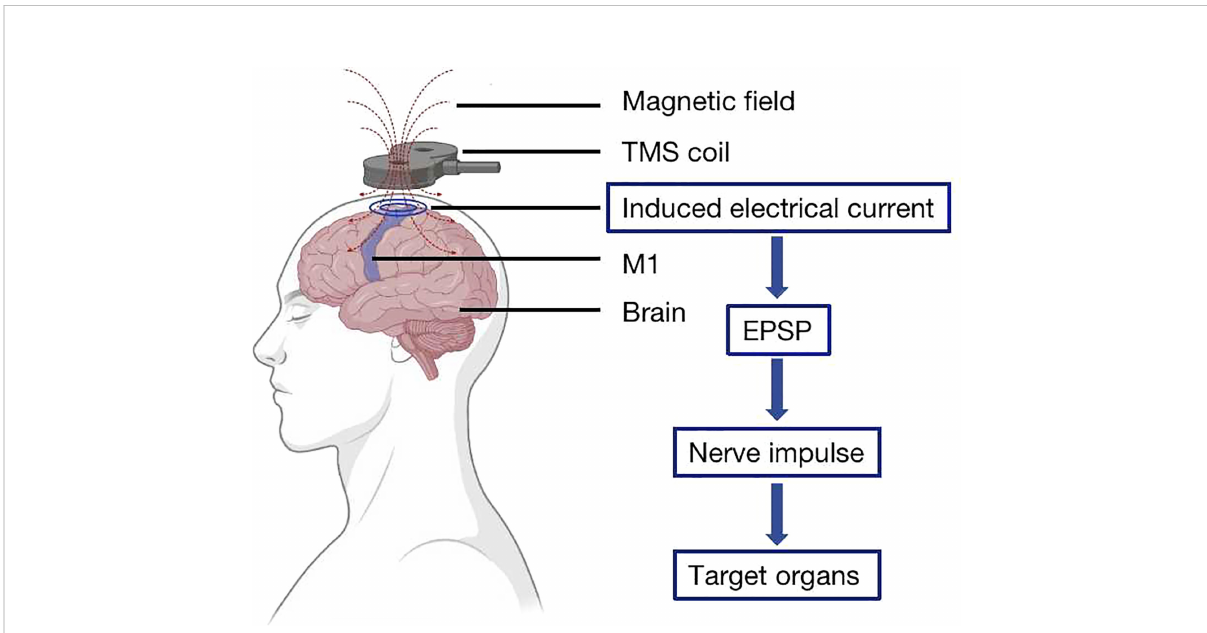
FIGURE 1 Transcranial magnetic stimulation (TMS) principle. The TMS coil is placed on the surface of the cerebral cortex, and the magnetic fi eld that it generates induces an electrical current in the interneurons located on the corresponding area of the brain, causing the neurons to produce excitatory postsynaptic potential, which generates nerve impulses to the governing